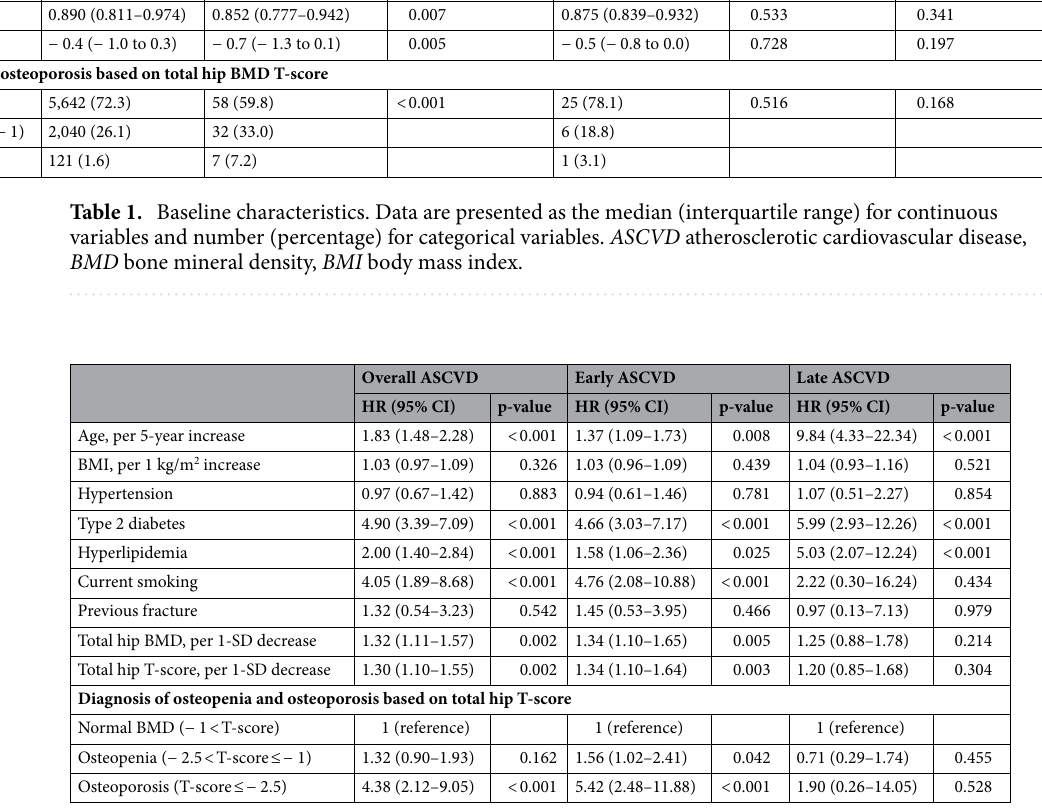
Table 2. Univariate assessment of risk factors for ASCVD. ASCVD atherosclerotic cardiovascular disease, BMD bone mineral density, BMI body mass index, CI confidence interval, HR hazard ratio, SD standard